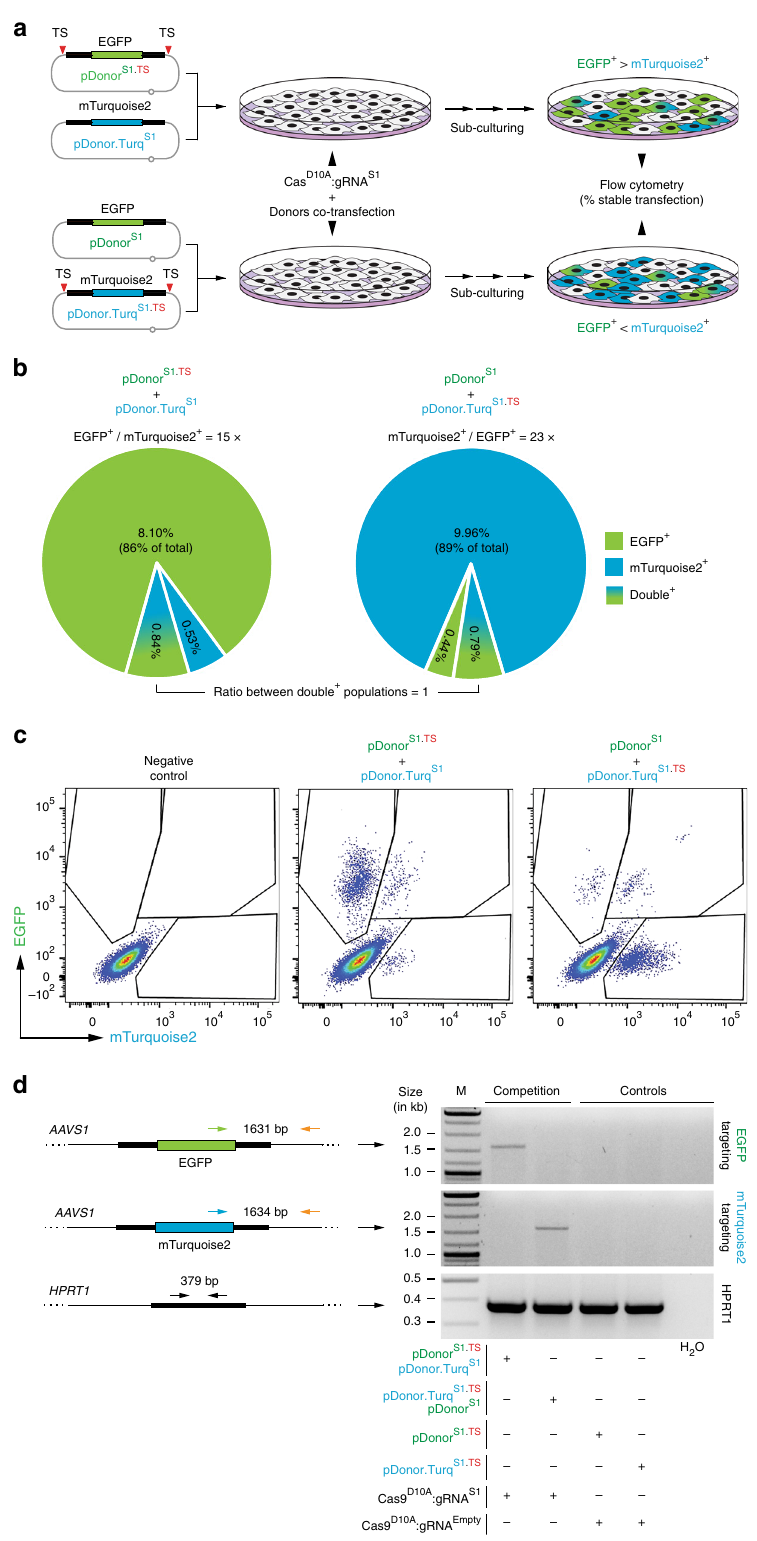
Fig. 4 Competition for gene targeting between donor DNA resistant and sensitive to RGN-induced nicking. a Schematics of the experimental design. HeLa cells were co-transfected with the indicated donor templates together with plasmids encoding nicking Cas9 D10A :gRNA S1 . b Quanti fi cation of stably transfected cell populations. The frequencies of genetically modi fi ed cells were determined at 27 days post-transfection by EGFP-directed and mTurquoise2-directed fl ow cytometry. The ratios between the frequencies of the various gene-modi fi ed subpopulations are presented. c Flow cytometry dot plots corresponding to the end-point of the experiments. Mock-transfected cultures served to set the thresholds for background fl uorescence (negative control). d Gene targeting in cells containing donor DNA resistant and susceptible to RGN nicking. Amplicons diagnostic for homology-directed gene targeting involving EGFP-encoding and mTurquoise2-encoding donor templates are indicated. HPRT1 provided for an internal control target